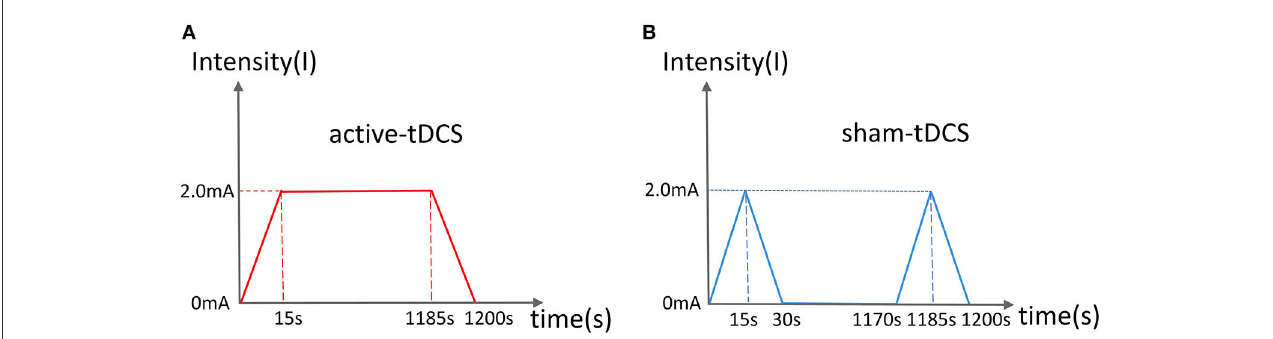
FIGURE2 Current schematic diagram of active (A) and sham (B) tDCS. (A) The current rises and falls for 15s, and lasts for 20min. (B) The current rises and falls for 15s and lasts for 1 min.